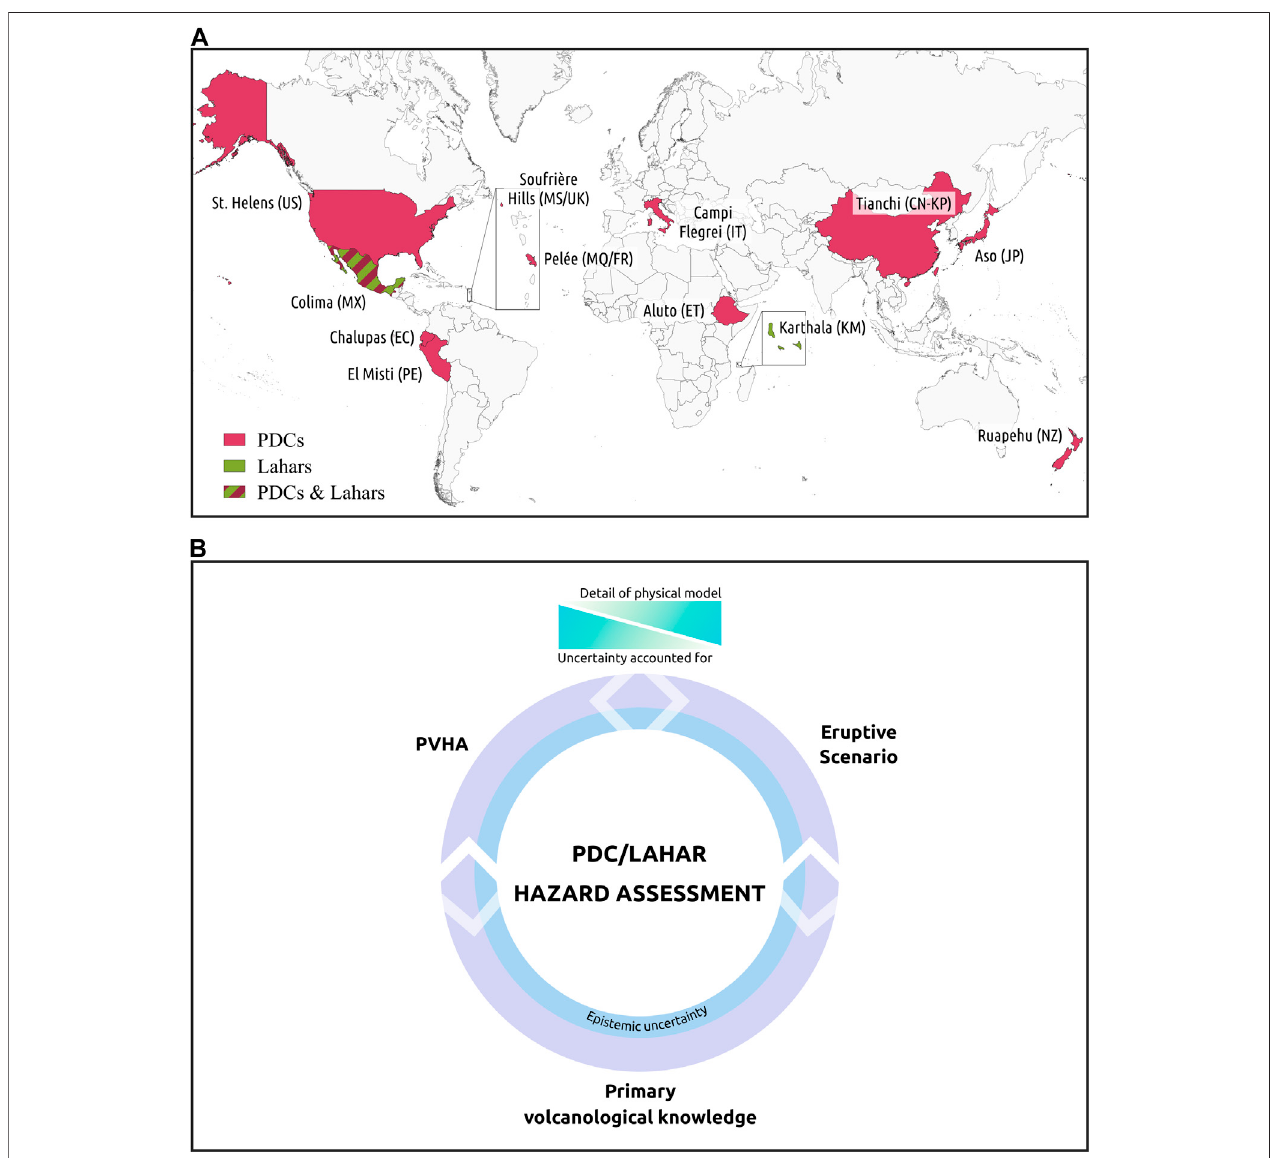
FIGURE1| Summaryofpresentandfutureglobalperspectivesinthe fi eldofvolcanichazardassessmentofpyroclasticdensitycurrents(PDCs)andlaharsderived from this Research Topic. (A) Globaldistribution ofcountries where volcanicsystems have been analyzed in theResearch Topic, divided according to whether the main object of study were PDCs or lahars (NB. Two different studies, one for PDCs, Patra et al ., and another for lahars, Walsh et al ., were presented for Volcán de Colima, Mexico). Map generated using Quantum Geographical Information System (QGIS Development Team, 2021), and Eurostat GISCO Geodata ( © EuroGeographics for the administrative boundaries, 1:3 Million Scale. Downloaded January 25, 2021). (B) Interrelationships between three main approaches commonly used in volcanic hazard assessment of PDCs and lahars. One is based on collating fundamental volcanological knowledge for the volcanic system of interest (and/or analogue volcanoes). Both scenario-based as well as probabilistic volcanic hazard assessments (PVHA) build upon this primary volcanological knowledge. Currently, there is a balancebetweenthedegree ofphysical detailand theuncertaintyaccountedforthatcanbeachievedwithscenario-basedandPVHAmethods.Wearguethatthethree approachesarecomplementaryandmutuallybene fi cial,andthattheyshouldbeincreasinglymergedinfuturehazardassessments.Wealsostressthekeyimportanceof acknowledging the presence of epistemic uncertainty on all three approaches, and of trying to quantify it as best as possible.